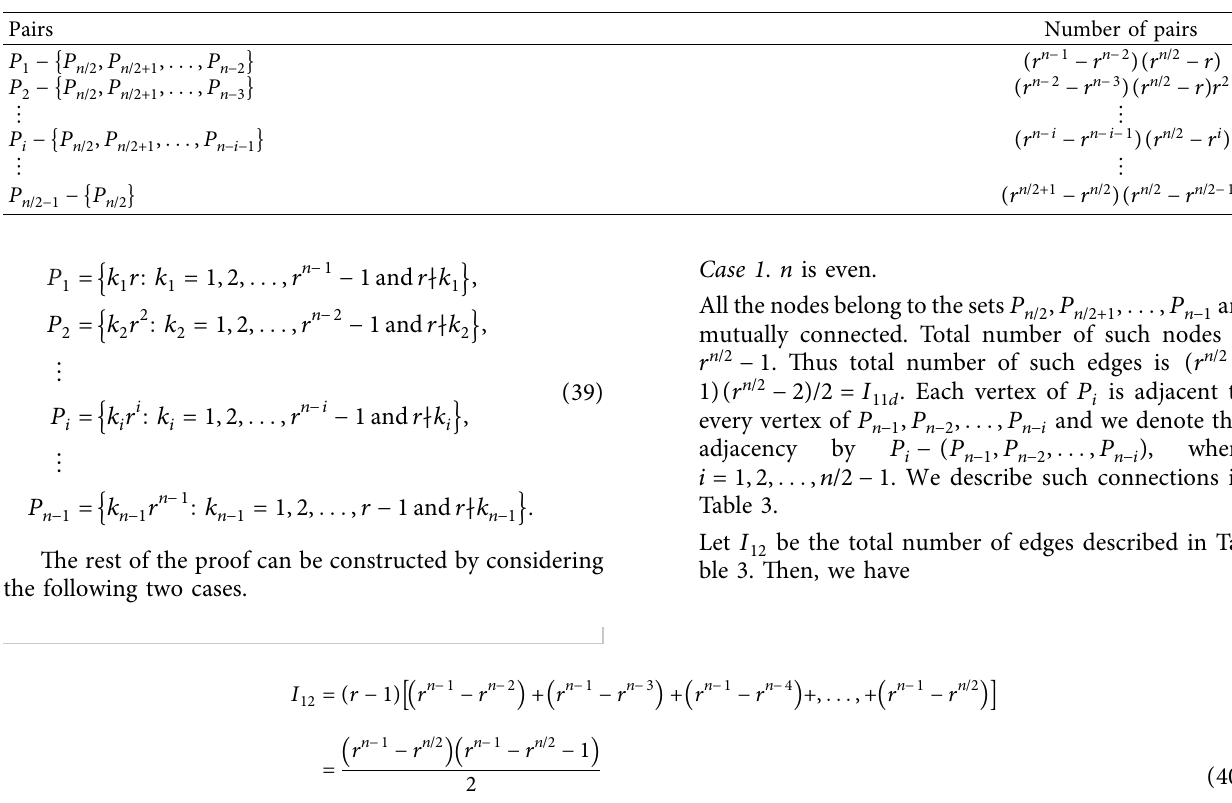
Table 4: Details of pairs having distance